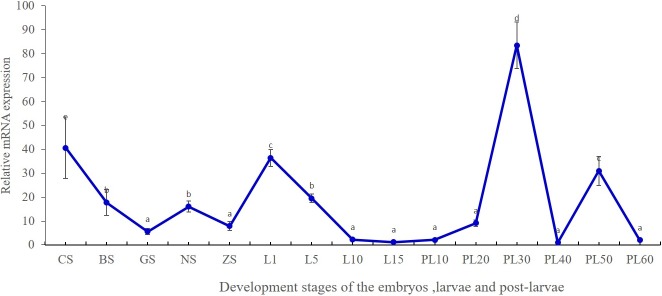
The temporal expression of Mn-MIH transcripts in different stages of embryo, larvae and post-larvae.Notes: The amount of Mn-MIH mRNA was normalized to the β-actin transcript level. Data were shown as means ± SD of three repeated samples during the larvae and post-larvae. CS-cleavage stage; BS-blastula stage; GS-gastrula stage; NS-nauplius stage; ZS-zoea stage. LI- the first day after hatching, PL10- the tenth day post-larvae after larvae, and so on.